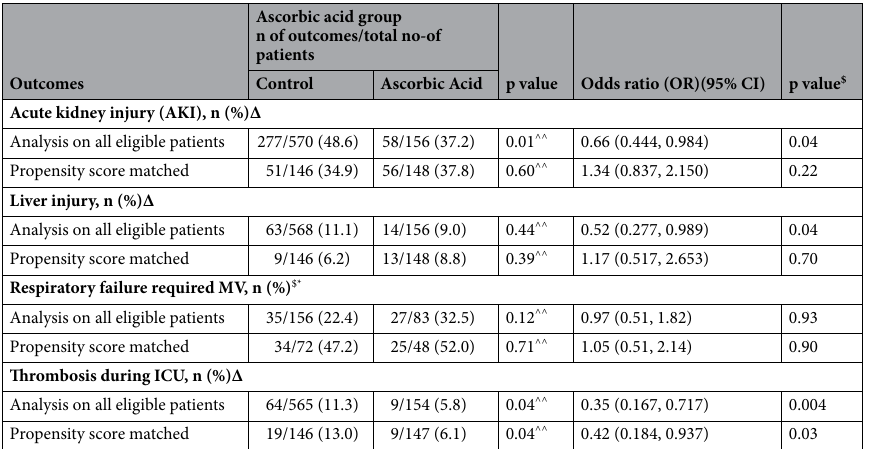
Table 2. Regression analysis for complication (s) during ICU stay. ∆ Denominator of the percentage is the total number of patients. ^^Chi-square is used to calculate the p value. $ Propensity score adjusted Logistic regression is used to calculate Odds ratio and p value. $* Denominator of the percentage is non-mechanically ventilated patients with 24 h of ICU